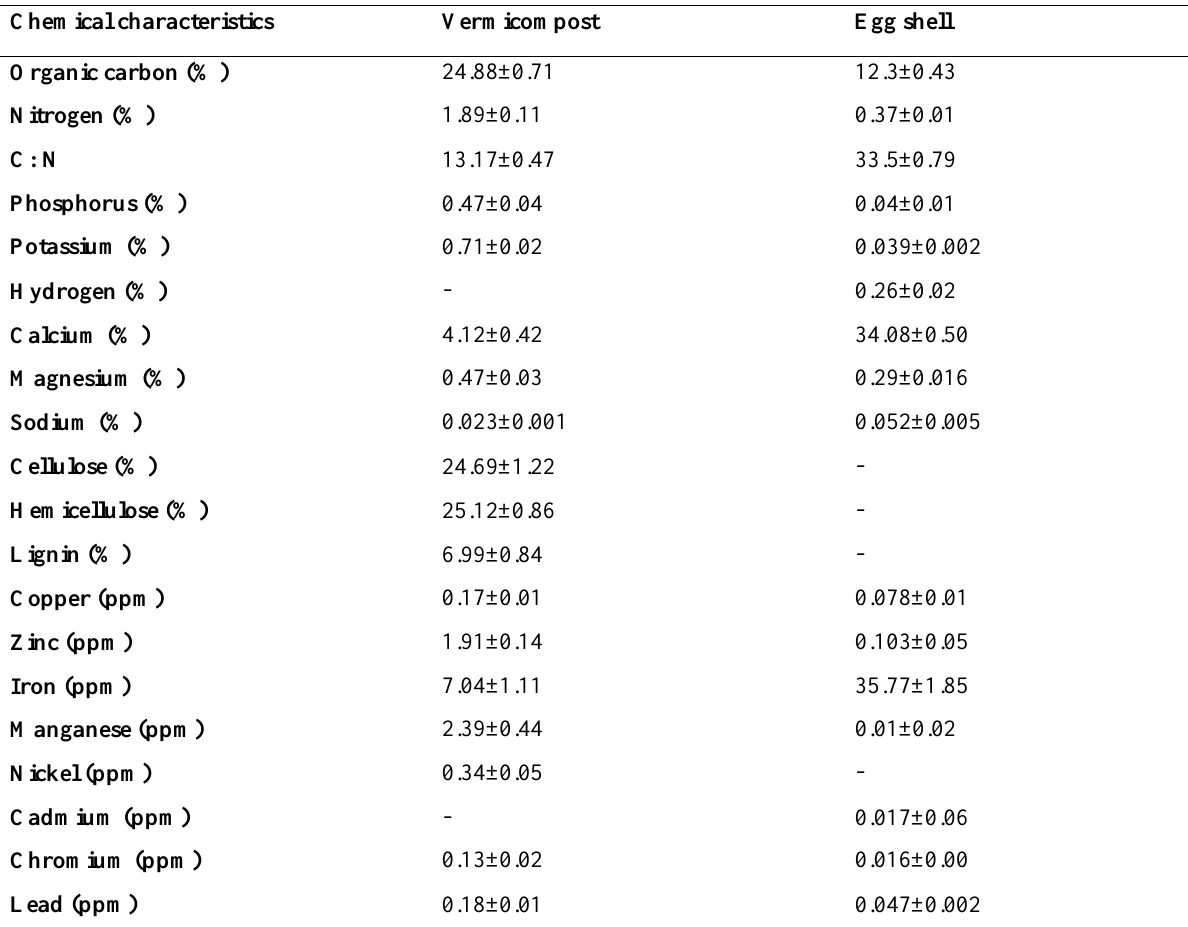
Table 1 Physicochemical properties of vermicompost and egg shell dust Chemical